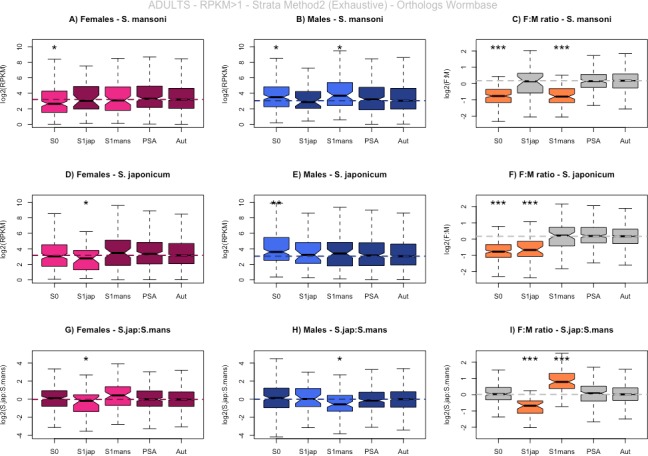
Adult expression patterns (RPKM>1, exhaustive strata, Wormbase orthologs) of genes located in the different strata of the Z (S0, S1man and S1jap), as well as pseudoautosomal and autosomal genes.The distribution of expression values is shown for (A) S. mansoni females, (B) S. mansoni males, (C) S. mansoni female:male, (D) S. japonicum females, (E) S. japonicum males, (F) S. japonicum female:male, (G) Female expression in S. japonicum divided by female expression in S. mansoni, (H) Male expression in S. japonicum divided by male expression in S. mansoni, (I) female:male ratio of expression in S. japonicum divided by female:male ratio of expression in S. mansoni. Asterisks represent levels of significance of comparisons to the control autosomal genes (*p-value<0.05, **p-value<0.001, ***p-value<0.0001). Genes were assigned to each Z-chromosome stratum based only on their coverage patterns; only genes with RPKM >0 were used. This figure differs from Figure 2-figure supplement 1 as the Wormbase Parasite list 1:1 orthologs was used instead of our own reciprocal best hit results.